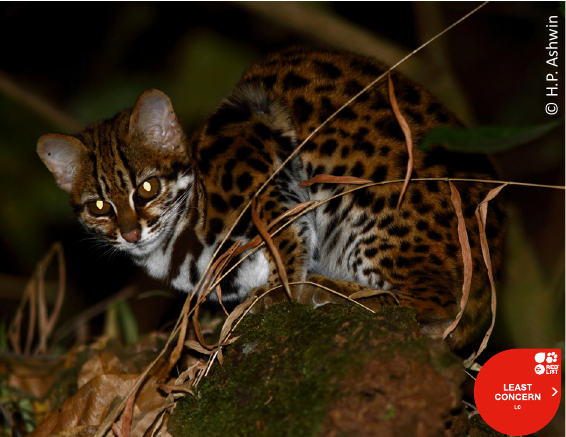
Image 6. Leopard Cat Prionailurus bengalensis